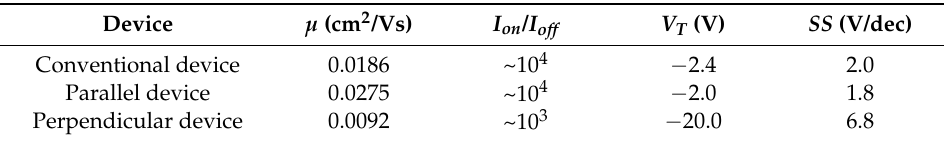
Figure 2. ( a – c ) Transfer characteristics curves of OTFTs obtained by two different annealing methods. Transfer curves ( d – f ) of OTFT sensors obtained by different annealing methods under a specific concentration of NO 2 ( V DS = − 40 V). Table 3. Field-effect mobility ( µ ), current on-off ratio ( I on / I off ), threshold voltage ( V T ), and subthreshold slope ( SS ) of different